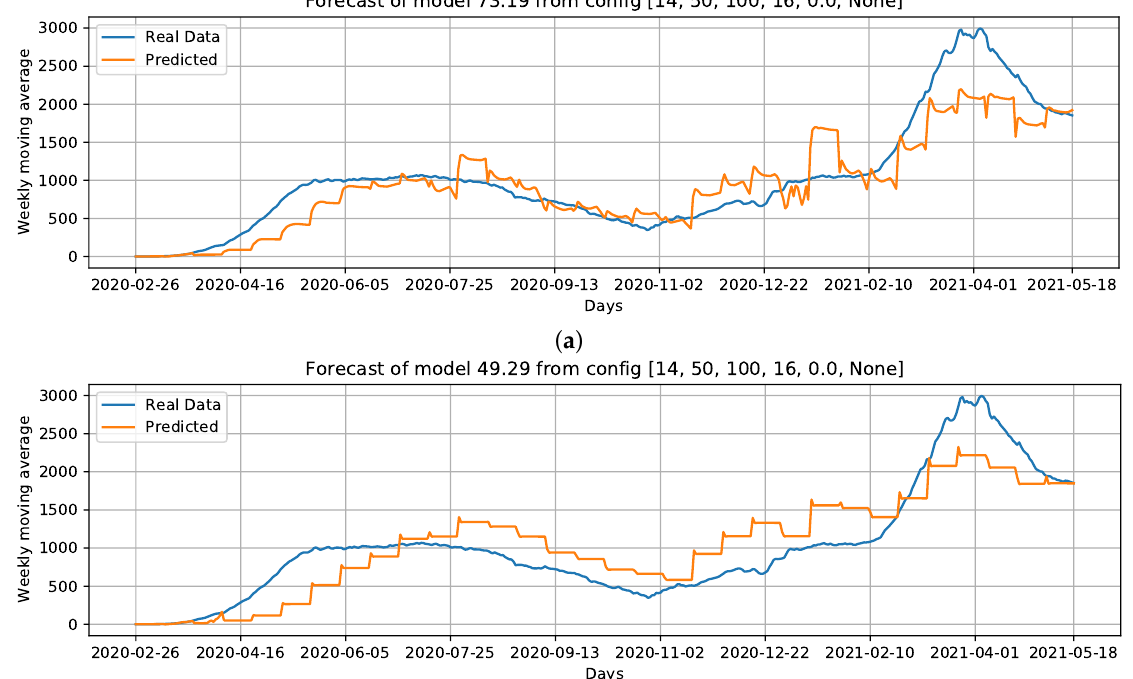
Other configurations, such as using the basic reproduction number ( number of cases + R 0 ) as input data, yielded more accurate results, with an average recorded RMSE of 173.84 (Figure 16b), which was an improvement of 18.99% over the baseline using only number of cases as input data. The use of R 0 and R e with the holiday flag (Figure 16c) produced an RMSE median error of 177.08. This was another configuration that should be highlighted with a higher accuracy of 17.48% over the baseline using only cases as input data. When comparing the generated curves by the model and the COVID-19 daily deaths ground truth (Figure 17), we observed that the R 0 provided stability in forecasting and reducing the noise in the predicted curve (Figure 17b). However, we noticed that there is a time shift of approximately a week in the predictive curve in certain periods. Considering Figure 17c, generated from the adoption of R 0 , R e , and the holiday flag, we observed this time shift problem was solved, despite an increase in RMSE error compared to the previous curve (Figure 17b). Nevertheless, a better and more accurate prediction of deaths caused by COVID-19 was achieved.